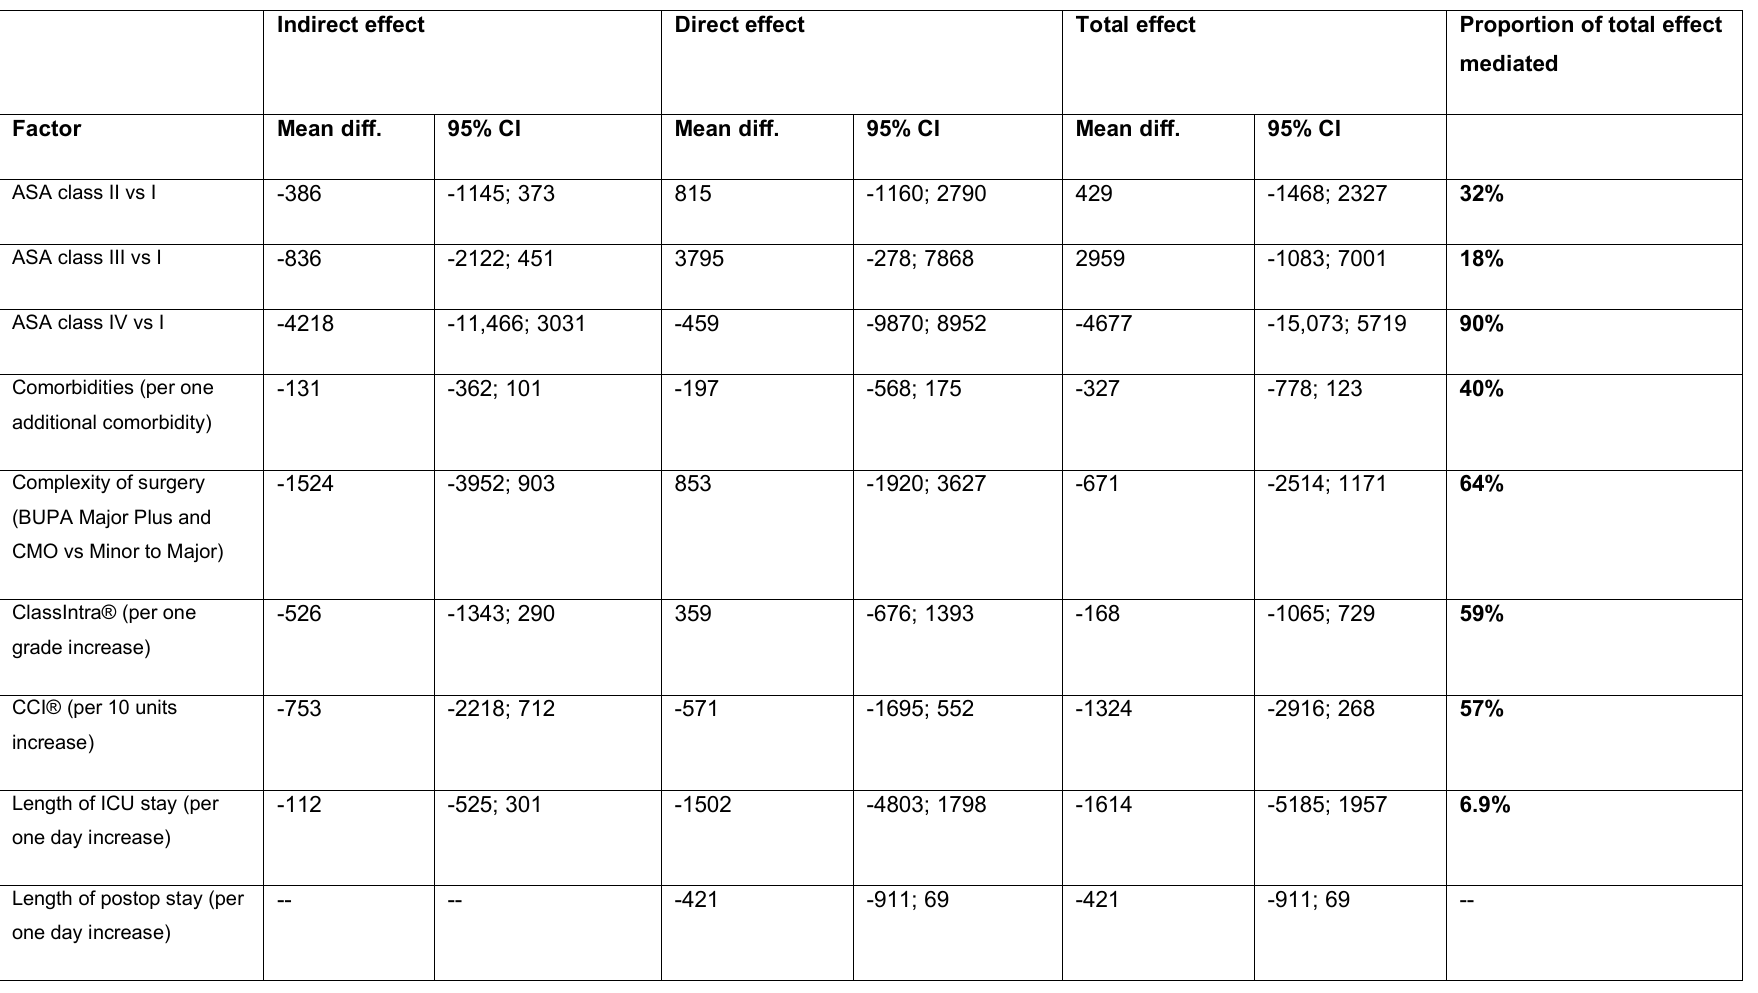
Table 13: Main reimbursement model excluding semi-privately and privately insured patients (in Euros) Coefficients are mean differences in reimbursement; patients with a protracted hospital or ICU stay, recurrent, semi-privately and privately insured patients and patients who died during hospital stay were excluded. R-squared 53.7%